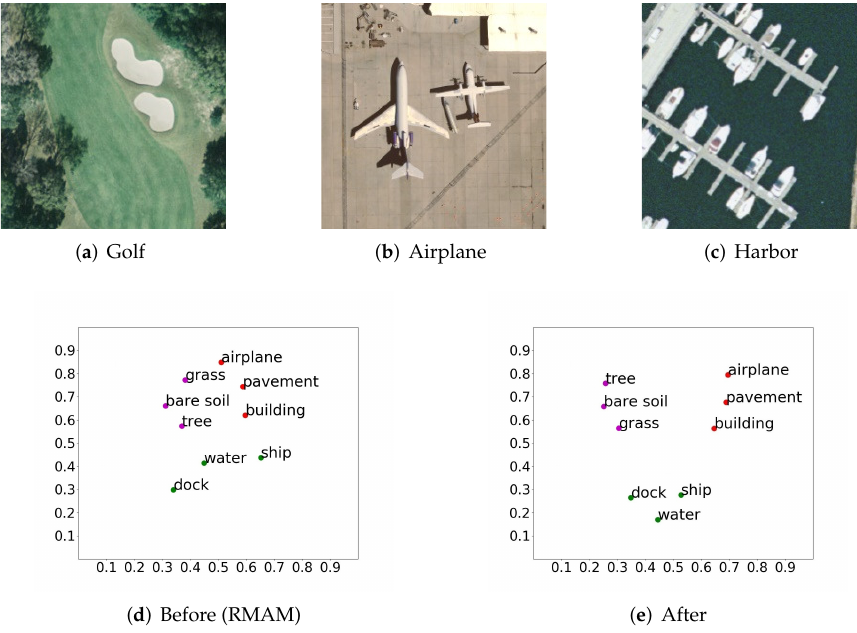
Figure 9. t-SNE visualization of visual feature vectors in the pictures before and after cross-modal alignment. In the training, we preserve two groups of trainable CNN parameters in the CM-GM framework, W 1 and W 2 , for attention propose and cross-modal alignment, respectively